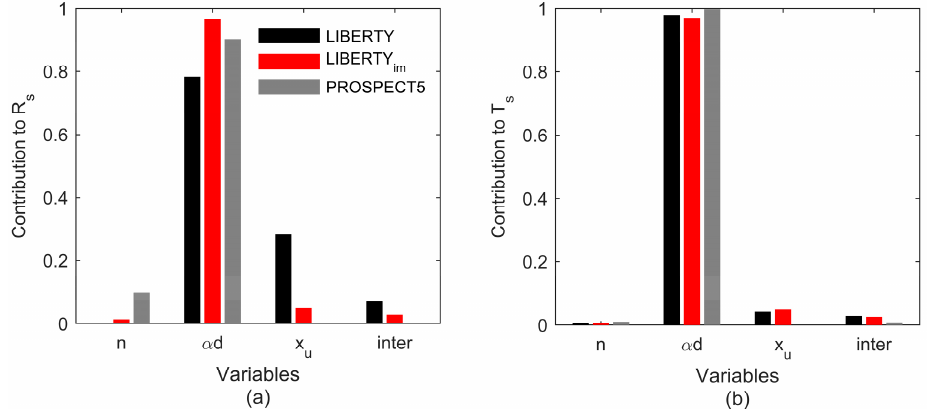
Figure 12. Results of global sensitivity coefficients of ( a ) the sublayer reflectance R s and ( b ) the sublayer transmittance T s to input variables using Sobel method. n is relative refractive index, α d is diametrical absorbance which is assumed to be equivalent to elementary layer absorbance in PROSPECT, x u is the particle backscattering ratio, and inter denotes the interactions among parameters. Input parameters for models are listed in Table 4. Their ranges were taken from Table 1. The legend is given in the barplot.